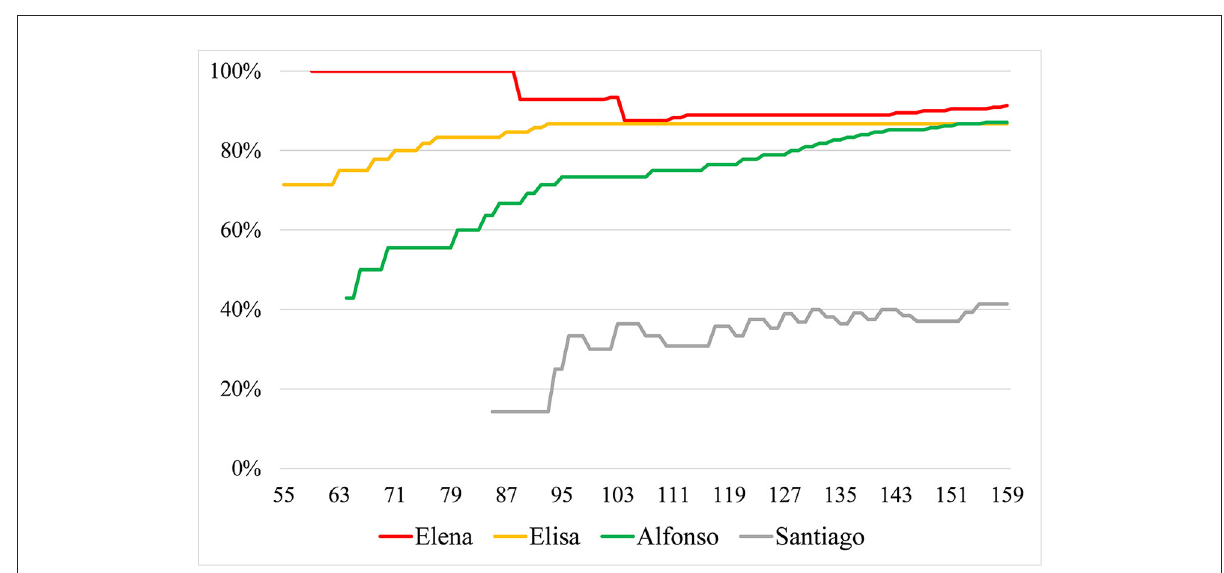
FIGURE2 Evolution of performances indicative of epistemic aims through the debate for each